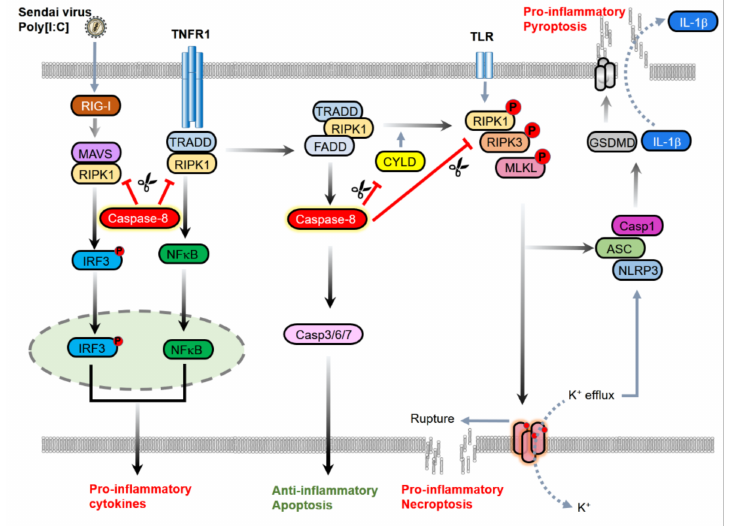
Figure 2. Caspase-8 contributes to the inhibition of inflammation through the induction of apoptosis, inhibition of necroptosis, and limiting of proinflammatory processes. Upon stimulation of death receptors, such as TNFR1, caspase-8 forms a complex with FADD, RIPK1, and Tumor necrosis factor receptor type 1-associated DEATH domain protein (TRADD) and is activated. The activated caspase-8 induces apoptotic cell death through the processing of effector caspases, such as caspase-3, -6, and -7. Caspase-8 inhibits necroptosis, a cell death mode that leads to inflammation by targeting the pro-necroptotic molecules RIPK1, RIPK3, and CYLD. In addition, caspase-8 is required for the inhibition of Toll-like receptor (TLR)-induced, MLKL-mediated inflammasome activation. The caspase-8 cleavage of RIPK1 also contributes to limiting proinflammatory cytokine production mediated by NF- κ B or IRF3 in response to TNF or Sendai virus. Blue arrows indicate activation and red blunt arrows represent inbibition. The blue dot arrows indicate the release of